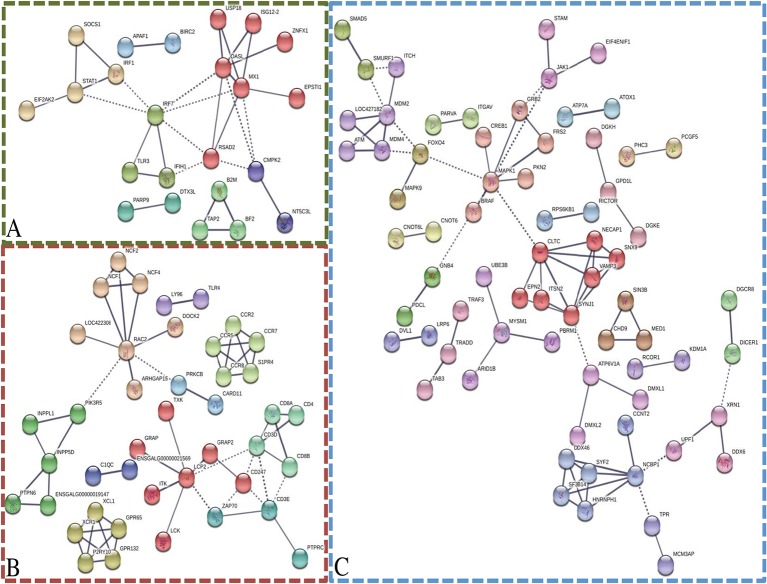
Network analysis of modules of interest. STRING was utilized to generate networks based on the associated gene name of the transcripts within the modules of interest: darkolivegreen module (A), darkred module (B), and steelblue module (C). Disconnected nodes were removed, high confidence (0.700), and MCL clustering (inflation = 3). Solid lines indicate connections within cluster and dotted lines indicate connections between clusters.